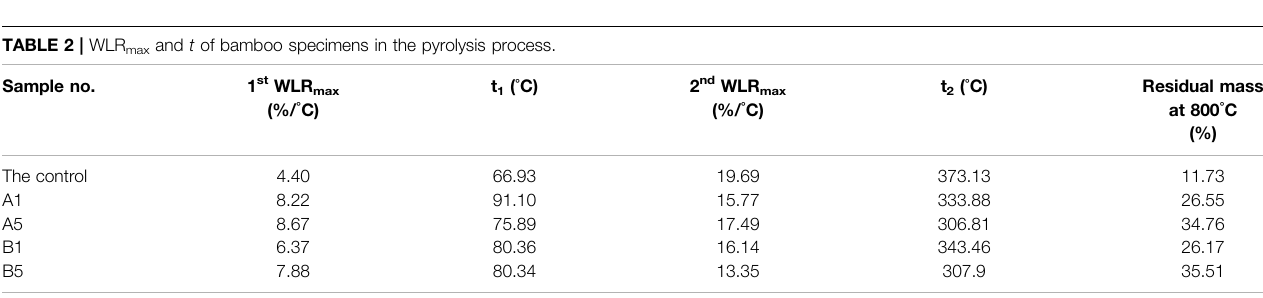
TABLE 2 | WLR max and t of bamboo specimens in the pyrolysis process. Sample